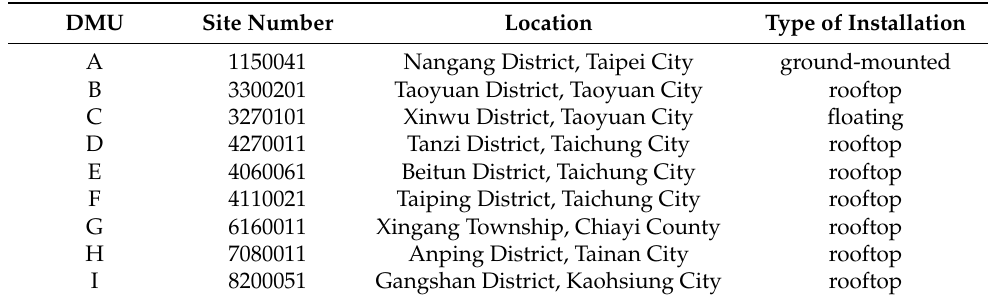
Table 1. List of Solar PV power plants. DMU Site Number